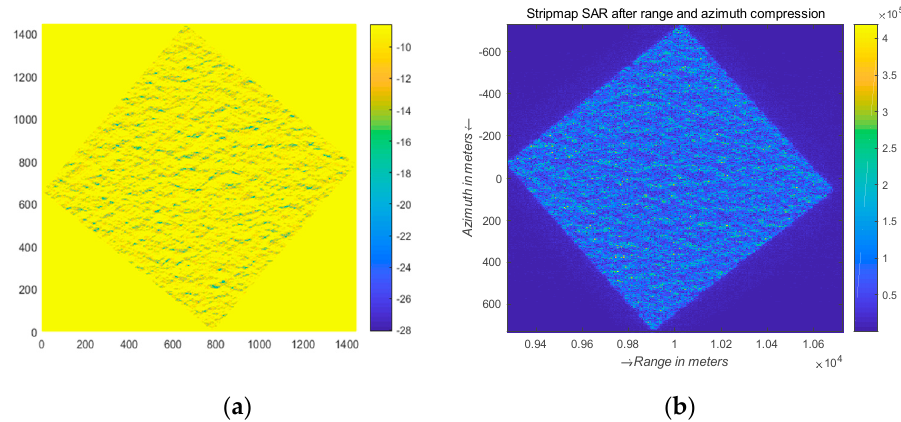
Figure 10. Data observed by SAR-3 as follows: ( a ) ocean surface backscattering coefficient and ( b ) ocean SAR image.